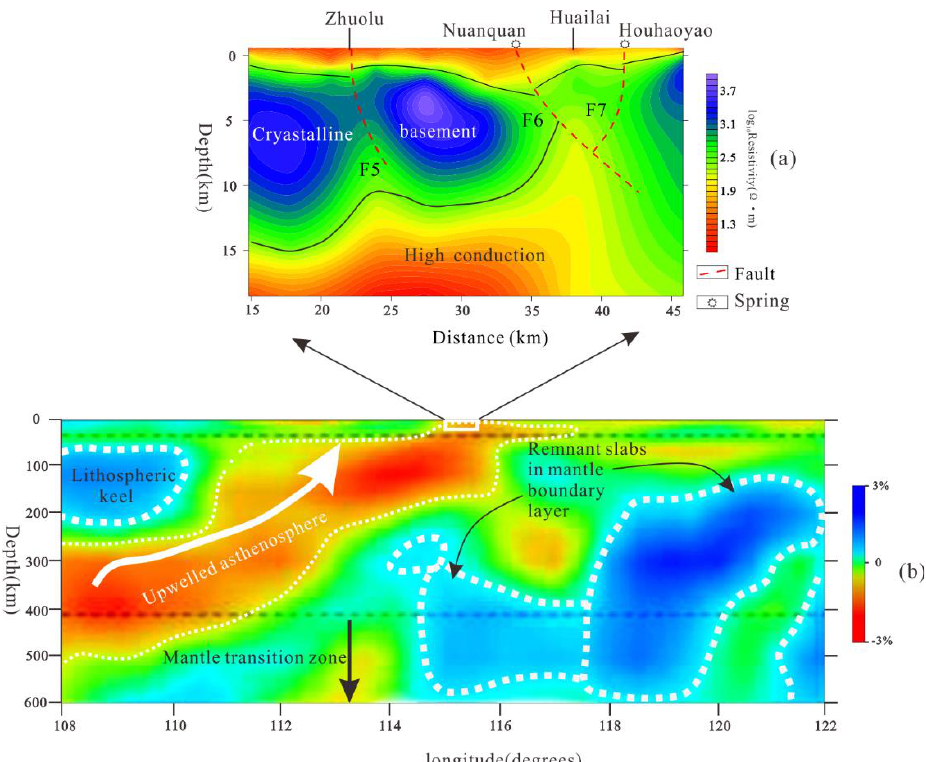
Figure 9. Underground structure of the Huailai area. ( a ) MT inversion results (modified from [40]); ( b ) P-wave seismic tomography (modified from [38]).